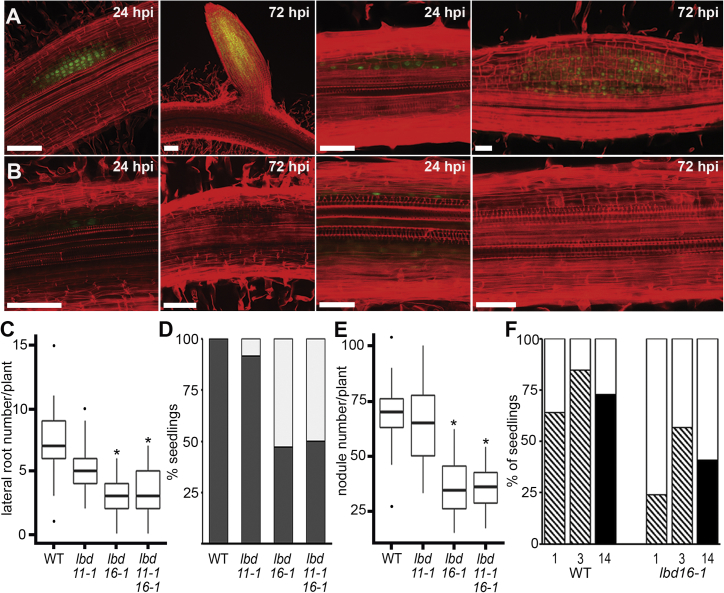
Lateral Root and Nodule Number Are Reduced in lbd16(A and B) Optical sections of lateral roots and nodules in (A) wild-type (WT) and (B) lbd16-1 at 24 or 72 hpi. Scale bars: 50 μm.(C) Lateral root number in 14-day-old seedlings. Boxplots show median (thick line), second to third quartiles (box), minimum and maximum ranges (lines), and outliers (single points). A one-way Kruskal-Wallis rank-sum test showed that lateral root number is dependent on genotype; asterisks indicate significantly different (95% confidence) means compared with WT. n = 56 (WT), 58 (lbd11-1), 64 (lbd16-1), and 66 (lbd11lbd16).(D) Percentage of gravi-stimulated seedlings with ≥1 lateral roots (dark gray) or 0 lateral roots (white) in the bend 5 dpi in WT (n = 25), lbd11-1 (n = 60), lbd16-1 (n = 53), and lbd11lbd16 (n = 60) showing significant reduction in the number of emerging lateral roots in lbd16-1 and lbd11lbd16 compared to WT. p = 0.166, 7.401e−07, and 1.413e−06 respectively; Fisher’s exact test.(E) Nodule number 21 days post S. meliloti inoculation. n = 13 (WT), 15 (lbd11-1), 14 (lbd16-1), and 14 (lbd11lbd16). A normal distribution allowed a one-way ANOVA test revealing the mean number of nodules differed significantly between genotypes; asterisks indicate significantly different (95% confidence) means compared to WT.(F) Percentage of seedlings with ≥1 primordia (hashed), ≥1 emerged nodule (black), or no structure (white) developing at the spot inoculation site at 1, 3, and 14 days post inoculation (dpi; n = 116 WT and 142 lbd16-1). lbd16-1 showed significantly different rates of initiation of primordia or nodules at all time points: p = 0.003 (1 dpi), 0.022 (3 dpi), and 2.084e−04 (14 dpi); Fisher’s exact test.See also Figures S3 and S4 and Data S2A.